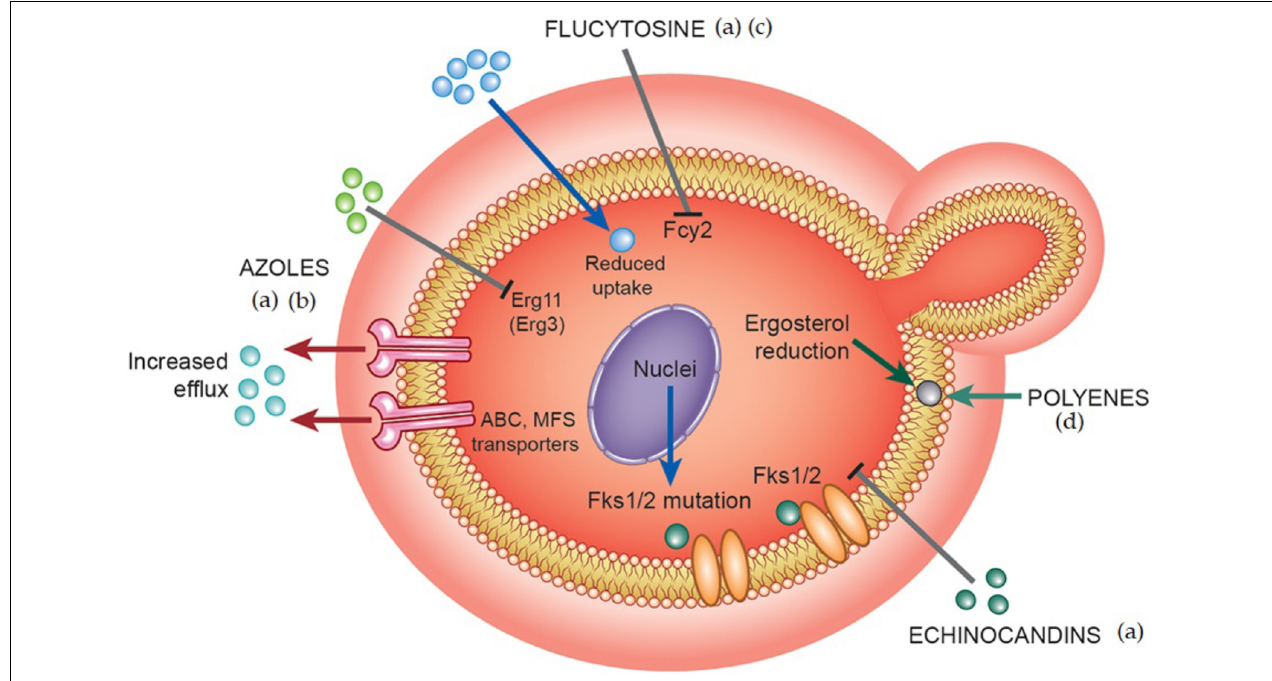
FIGURE 2 | Different mechanisms of multidrug resistance adopted by fungal cells. The main mechanisms of drug resistance against azoles, polyenes, echinocandins, and flucytosine include: (a) alteration of the enzyme target (genes encoding ergosterol biosynthetic pathway enzymes – AZOLES, glucan synthases – ECHINOCANDINS, cytosine deaminase or uracil phosphoribosyltransferase – FLUCYTOSINE) leading to poor binding of toxic drugs to its enzyme target sites, (b) overexpression of drug efflux proteins leading to increased efflux – AZOLES, (c) changes in membrane property/composition affecting normal drug import – FLUCYTOSINE, (d) Reduction of sterols in plasma membrane – POLYENES. Colored balls mean antifungal